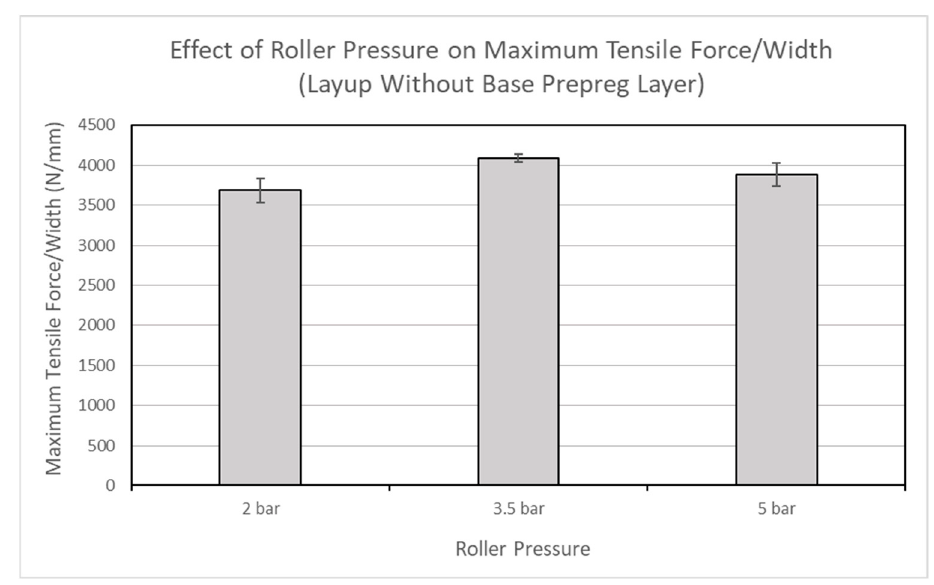
Figure 9. Effect of roller pressure on maximum tensile force/width for layups without base prepreg layer.